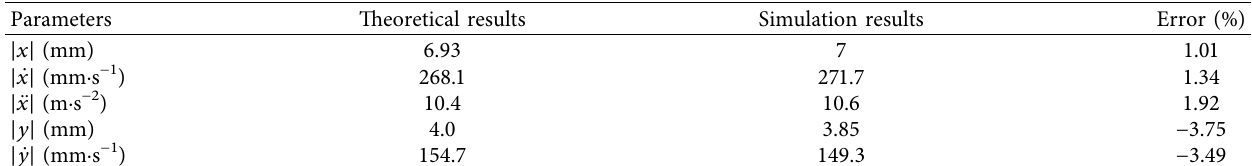
Figure 7: Time-responses of the acceleration about the NCDS. Table 1: Comparisons of theoretical results and simulation